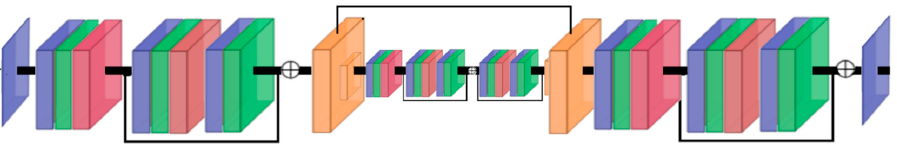
Figure 2. The neural network architecture for semantic segmentation on MSI; blue layers are convo- lutions, green ones represent batch normalizations, ReLU is in red, and the orange layers correspond to max pooling/unpooling layers.